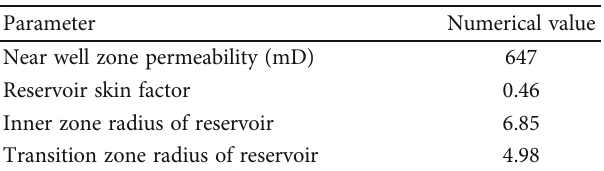
Figure 13: Fitting diagram of the double logarithmic curve of the well test data after measures were implemented in well A1. Table 2: Example interpretation